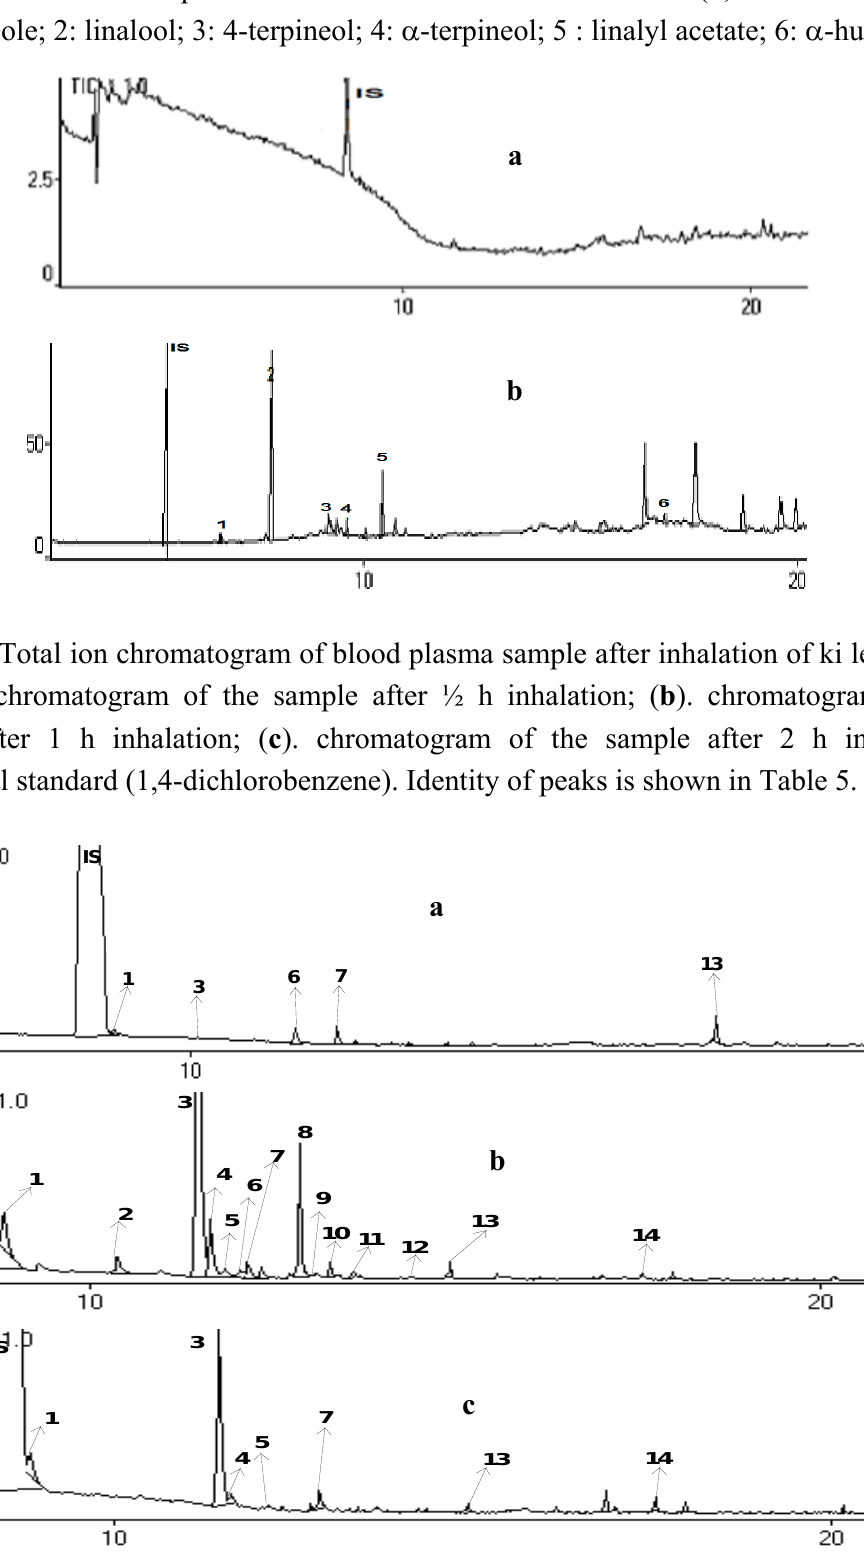
Figure 1. Total ion chromatogram of a blood plasma sample after 1 h inhalation of basil leaf oils. ( a ) sample preparation without SPE aid, no volatile compounds could be detected in blood plasma; ( b ) Sample preparation using SPE C-18, some volatile compounds were found in plasma.